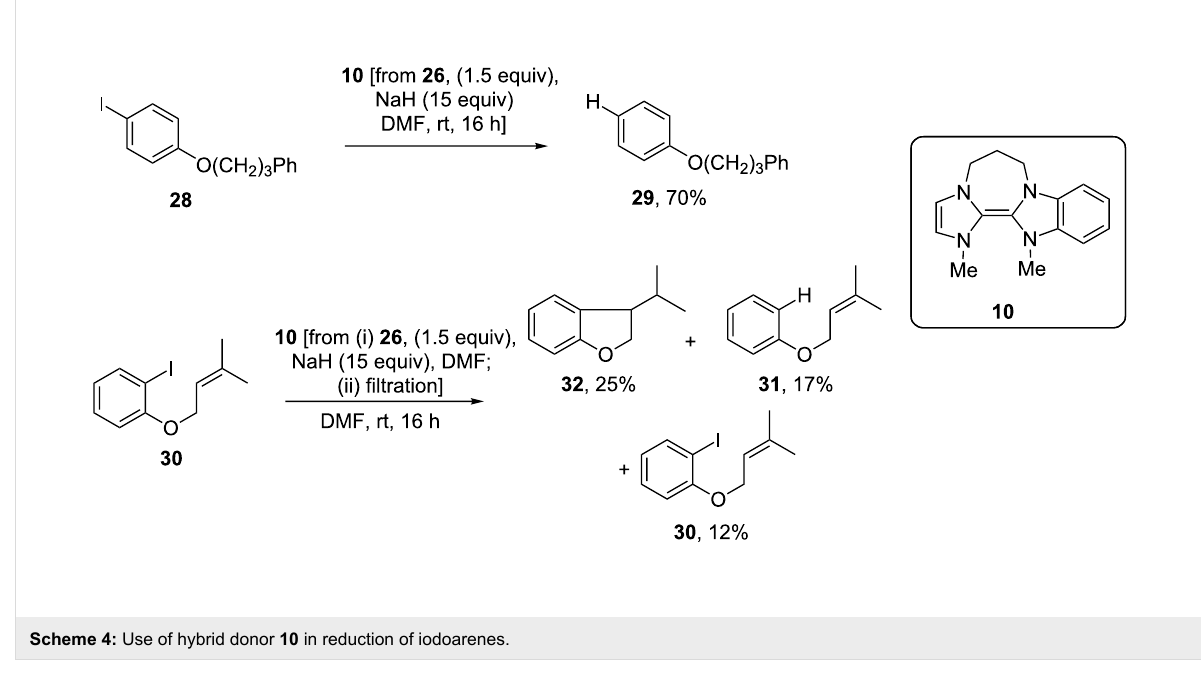
Scheme 4: Use of hybrid donor 10 in reduction of iodoarenes.